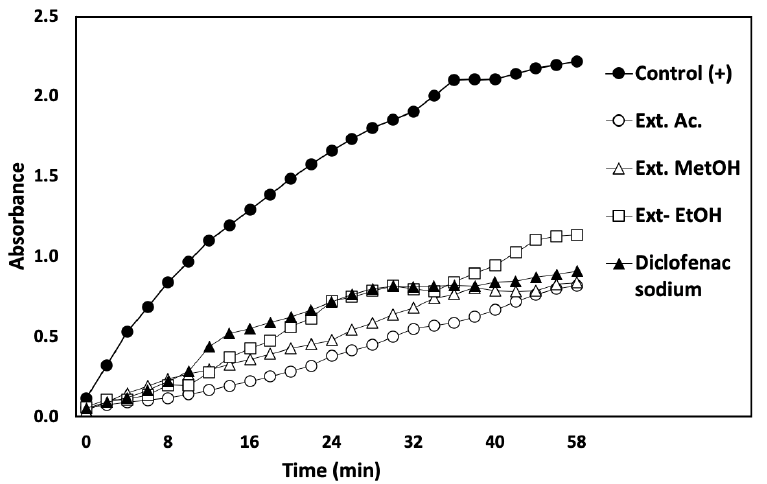
Figure 3. Anti-inflammatory activity evaluated by inhibition of elastase activity. Effect of the extracts on the inhibition of PPE. The absorbance increases when the p-nitroaniline is released. Control (+) Enzyme + substrate. Diclofenac sodium was used as anti-inflammatory control. The concentration of the extracts was 66.66 μg· mL −1 .